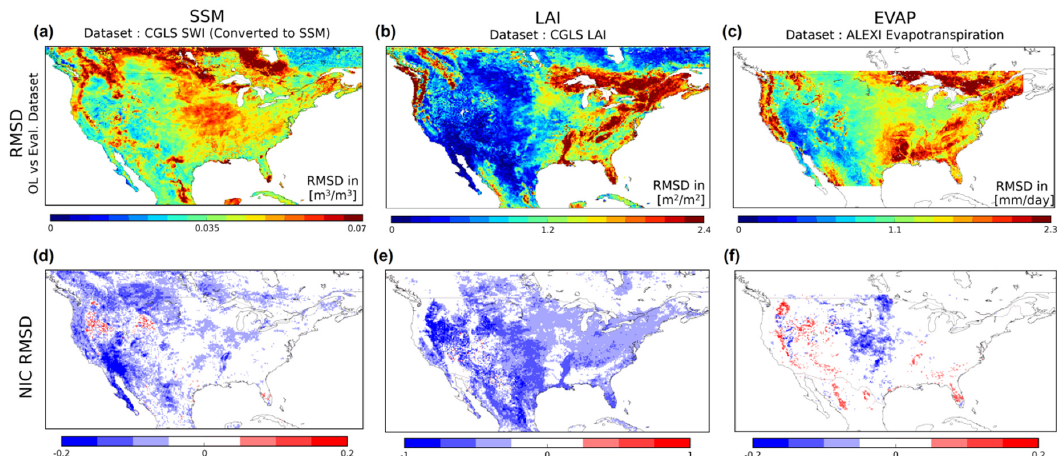
Figure 5. As in Figure 4, except for RMSD. Upper row maps ( a – c ) are of average temporal correlation between LDAS-Monde open-loop (OL) and satellite-derived products for SSM ( a ), LAI ( b ), and ET ( c ) at forecast day 1. Bottom row maps are average normalized information contribution (NIC) correlation impact from the SEKF assimilation for the same variables (( d – f ),